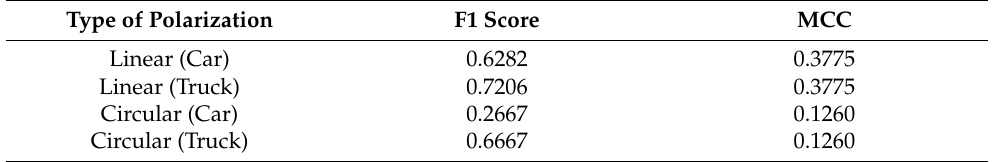
Table 2. Quality of binary